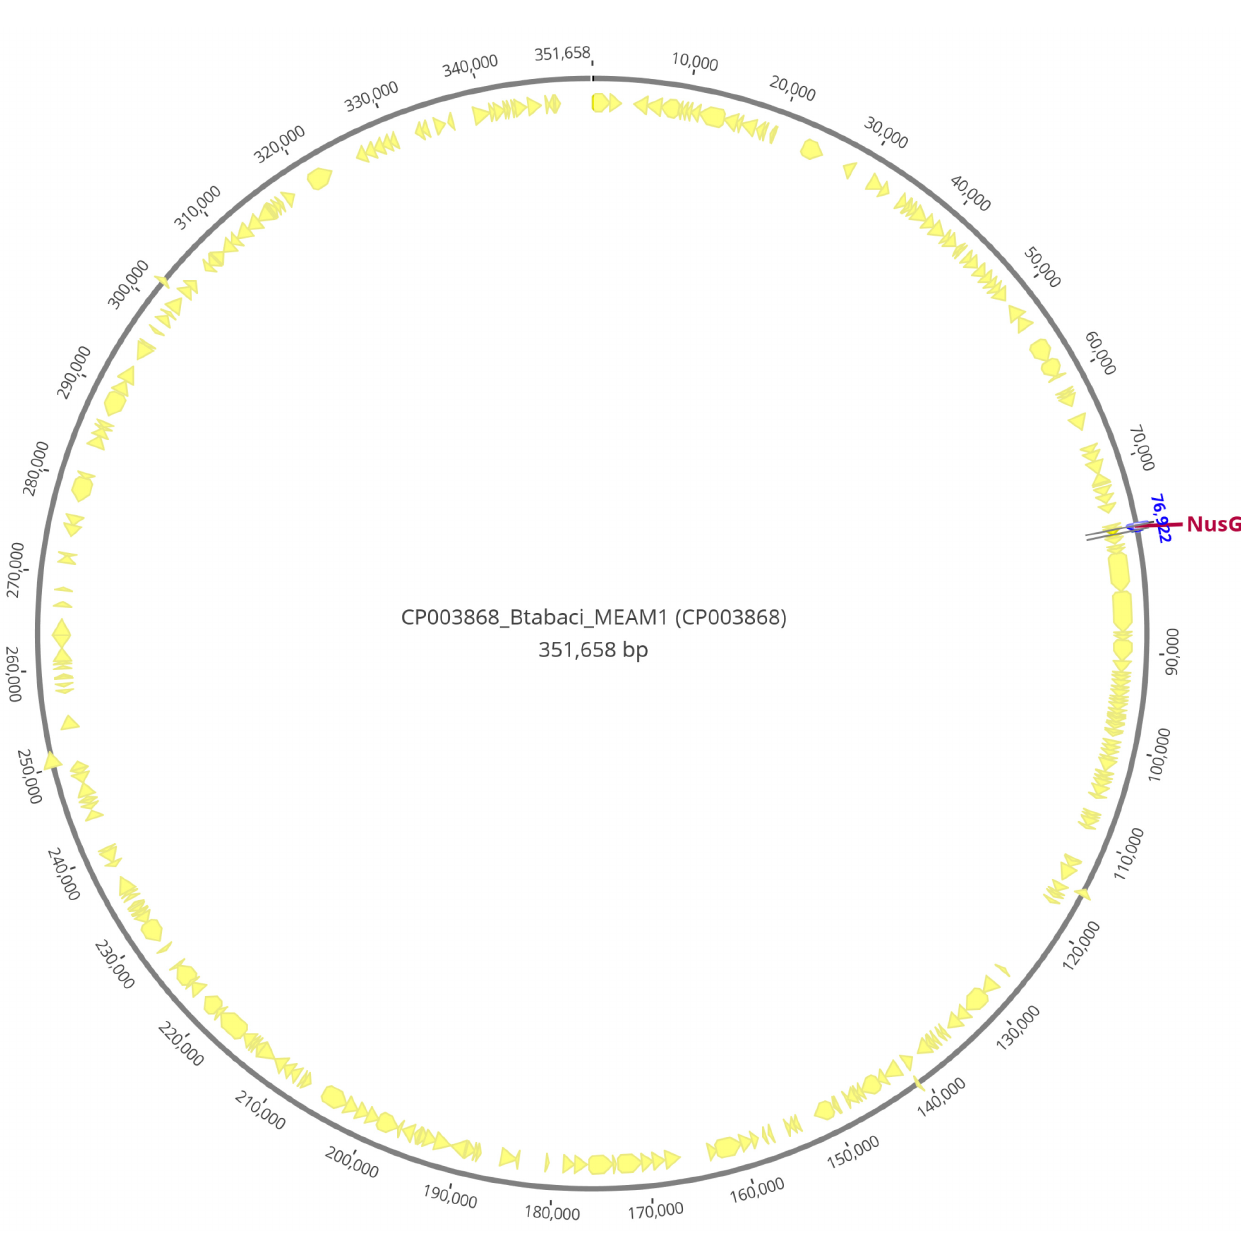
Figure 3. Primary endosymbiont Portiera aleyrodidarum whole genome from GenBank CP003868 showing the section of the NusG gene included in the analyses (position